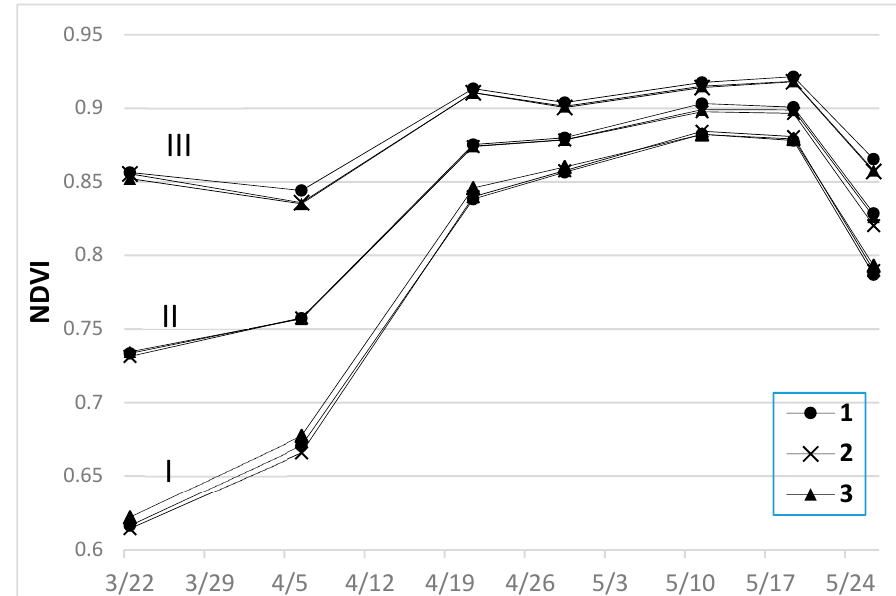
Figure 5. NDVI time series analysis, considering the three vigor classes as identified in the S2 image of March 22nd (I: NDVI ≤ 0.68; II: 0.68 < NDVI ≤ 0.79; III: NDVI > 0.79), for the three N fertilization treatments: 1) Flat-N (standard rate of 120 kg N ha − 1 ); 2) Var-N-low (variable rate from 60 to 120 kg N